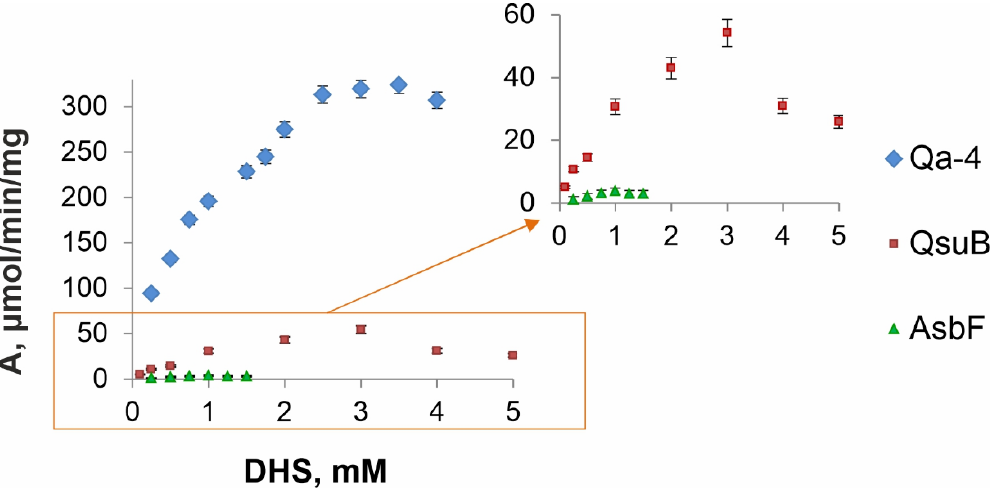
Figure 6. Kinetic curves of DSDs (pH 7.5, 20 °C). The dependence of protein activity on substrate concentration was generated in triplicate. Blue rhombuses represent Qa-4 activity; red squares and green triangles correspond to QsuB and AsbF activities, respectively. The orange frame highlights the area that is magnified in the right graph owing to the considerably higher specific activity of Qa-4 in comparison with that of QsuB and especially with that of AsbF. Table 3. Catalytic properties of DSDs (pH 7.5, 20 ◦